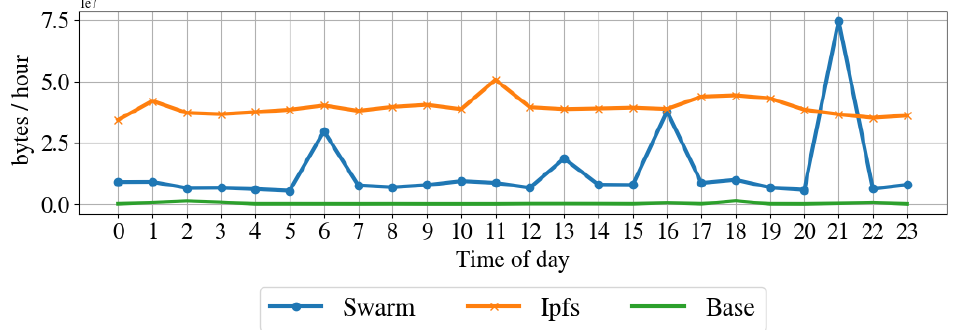
Figure 12. Network average received bytes per hour before and while running the proposed architec- ture with IPFS and